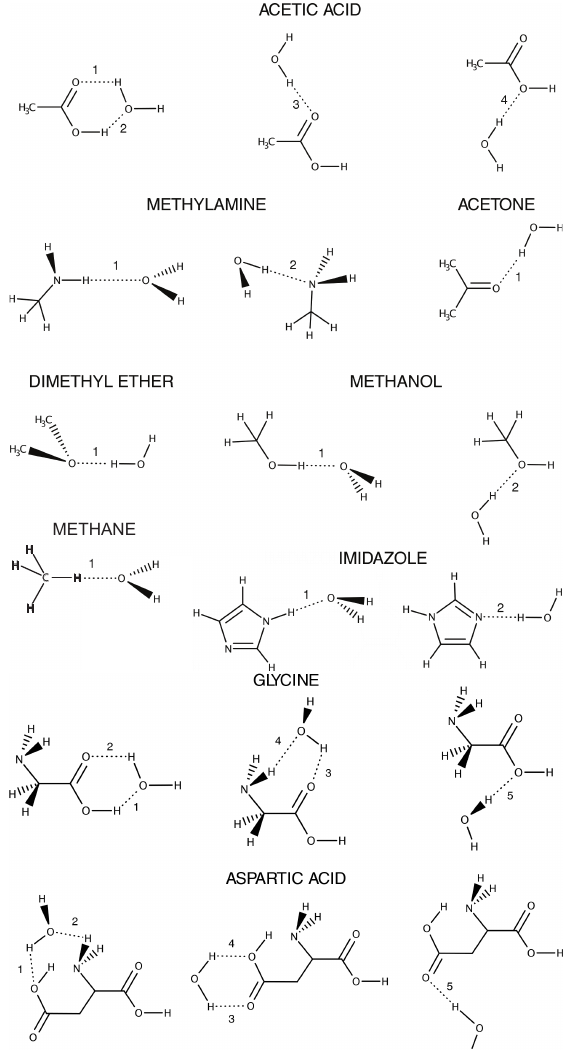
Figure A1. Structure and nomenclature of the di ff erent H-bond evaluated for di ff erent organic molecules / water pairs: acetic acid / water (1,2,3,4), methylamine / water (1,2), acetone / water (1), dimethyl ether / water (1), methanol / water (1,2), methane / water (1), imidazole / water (1,2), glycine / water (1,2,3,4,5), and aspartic acid / water (1,2,3,4,5). It is debatable whether the methane–water interaction can be called a hydrogen bond, but, since it is included in the original dataset, we also include it here.